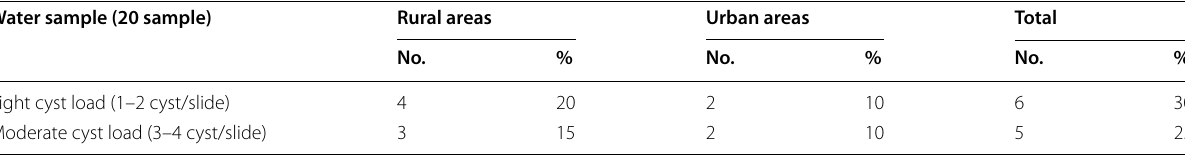
Table 1 Number of water samples contaminated by G. duodenalis cyst and cysts intensity Water sample (20 sample) Rural areas